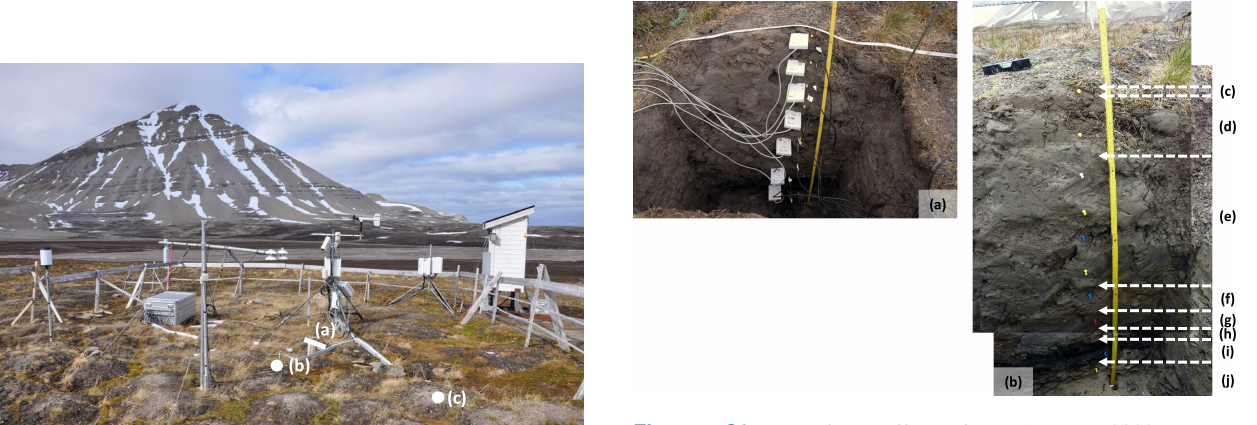
Figure C9. Bayelva soil station, August 2009–present, (78.92094 ◦ N, 11.83334 ◦ E). (a) TDR and temperature probe installation; (b) soil characteristics of the non-sorted circle; (c) moss layer (0–1cm), (d) loam with roots (1–15cm), (e) loam with few rocks (15–55cm), (f) loam with rocks (55–65cm), (g) dark loam with few rocks (65–77cm), (h) rocky layer with loam (89–95cm), (i) coal layer (81–95cm), (j) rocky layer (95–119cm). Soil data for texture and C, N and S are listed in Table